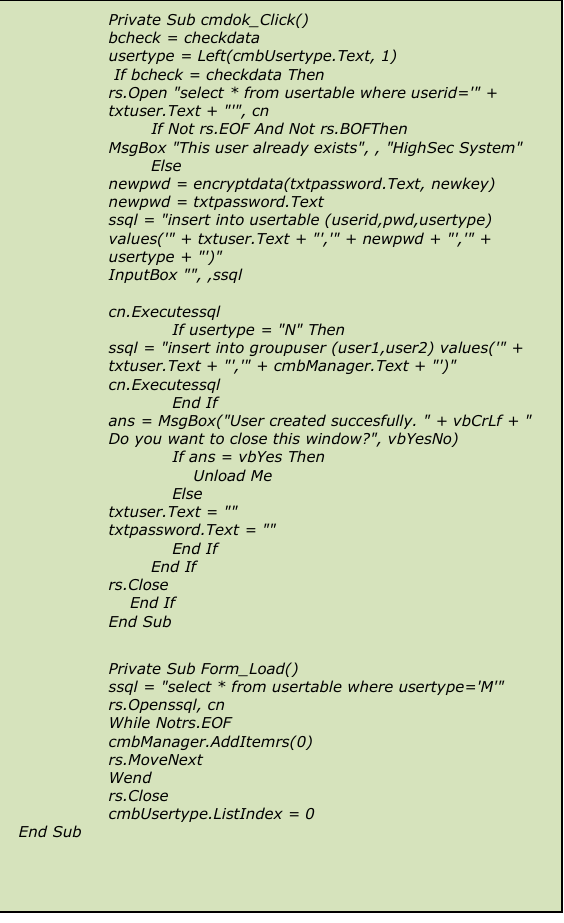
Code 1: Creating super-user and the verification